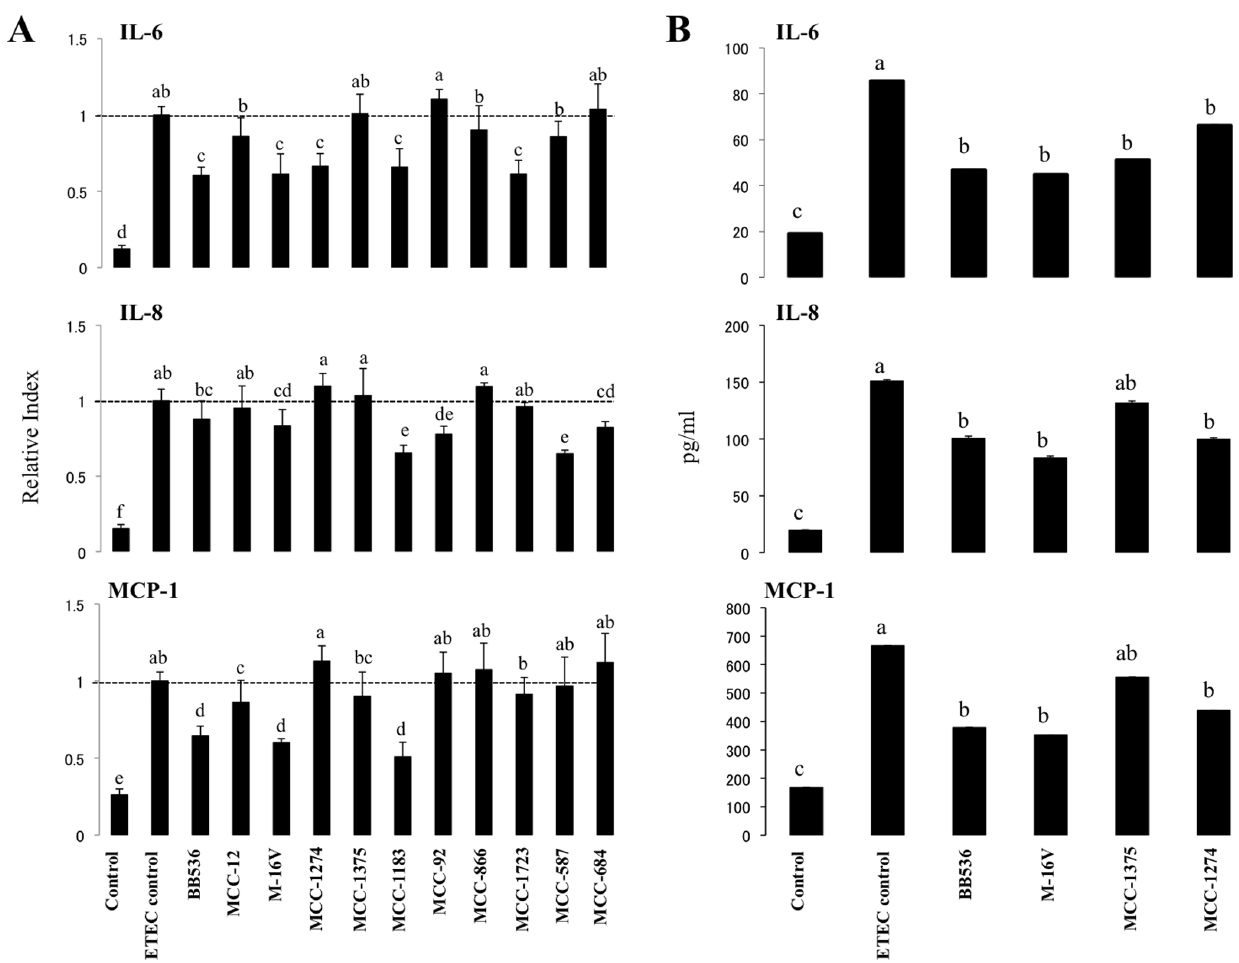
Figure 2. Expression of cytokines in porcine intestinal epithelial (PIE) cells after stimulation with heat-stable Enterotoxigenic Escherichiacoli (ETEC) pathogen-associated molecular patterns (PAMPs). PIE cells were pre-treated with different bacterial strains for 48 h and stimulated with heat-stable ETEC PAMPs. The expression of MCP-1, IL-6, and IL-8 mRNAs (A) and proteins levels (B) were studied at 12 h post- stimulation. The results represent four independent experiments. Different letters indicate significant differences (P , 0.05).